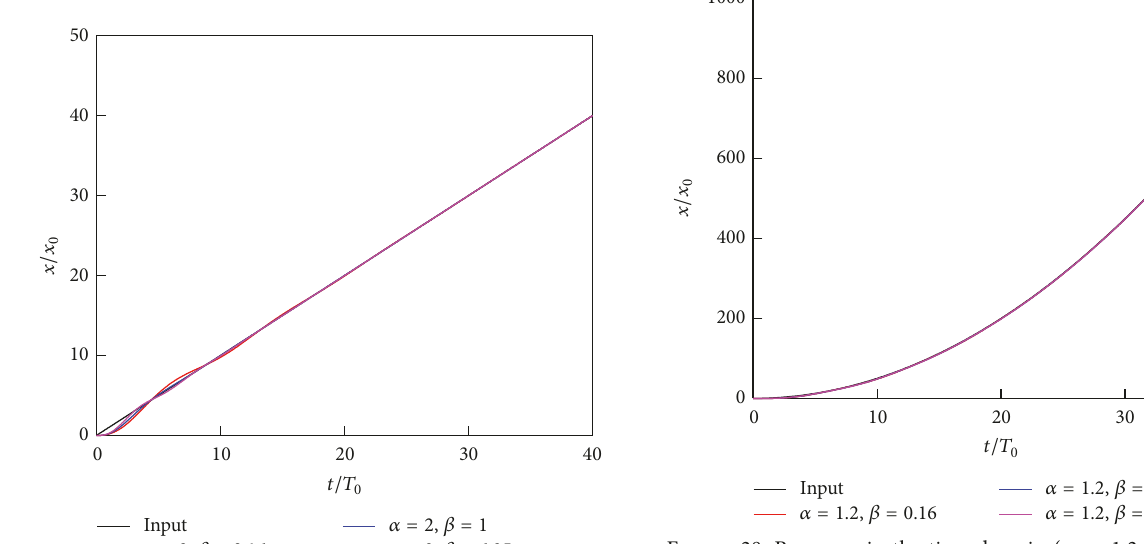
Figure 28: Response in the time domain ( 𝛼 = 1.2, 𝛽 = 0.16, 1, 6.25